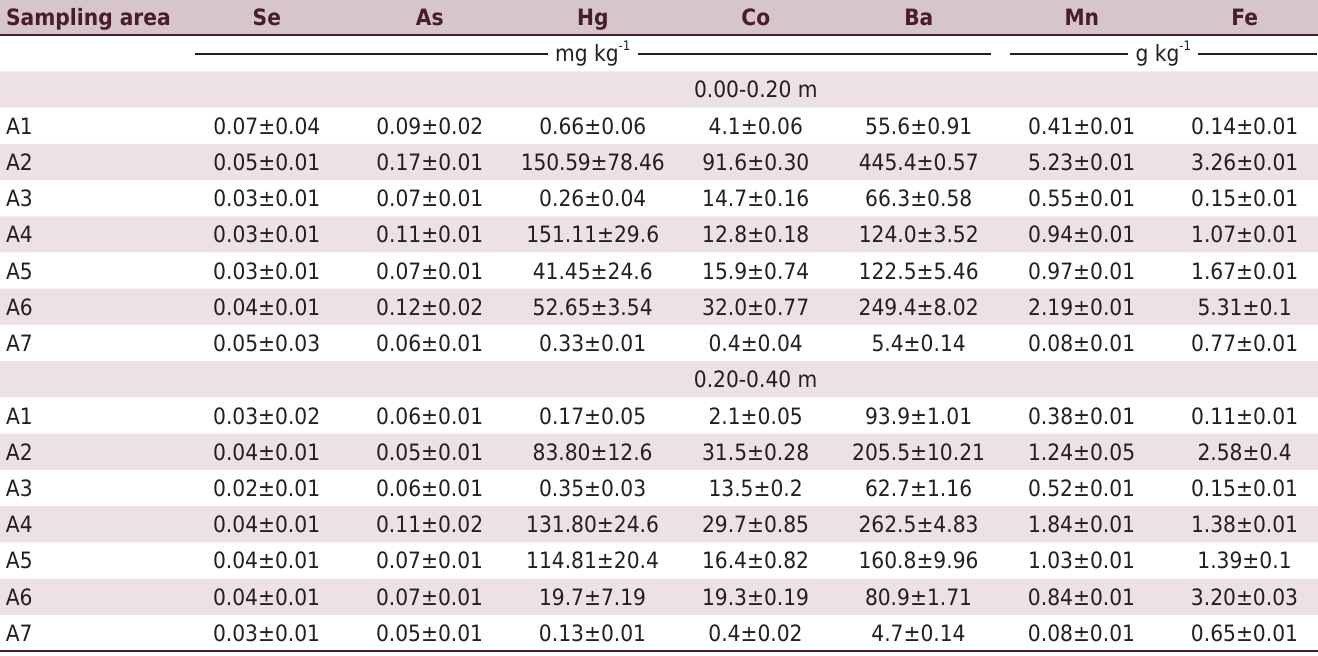
Table 6. Available contents of potentially toxic elements (PTEs) in soils and sediments from Serra Pelada Sampling